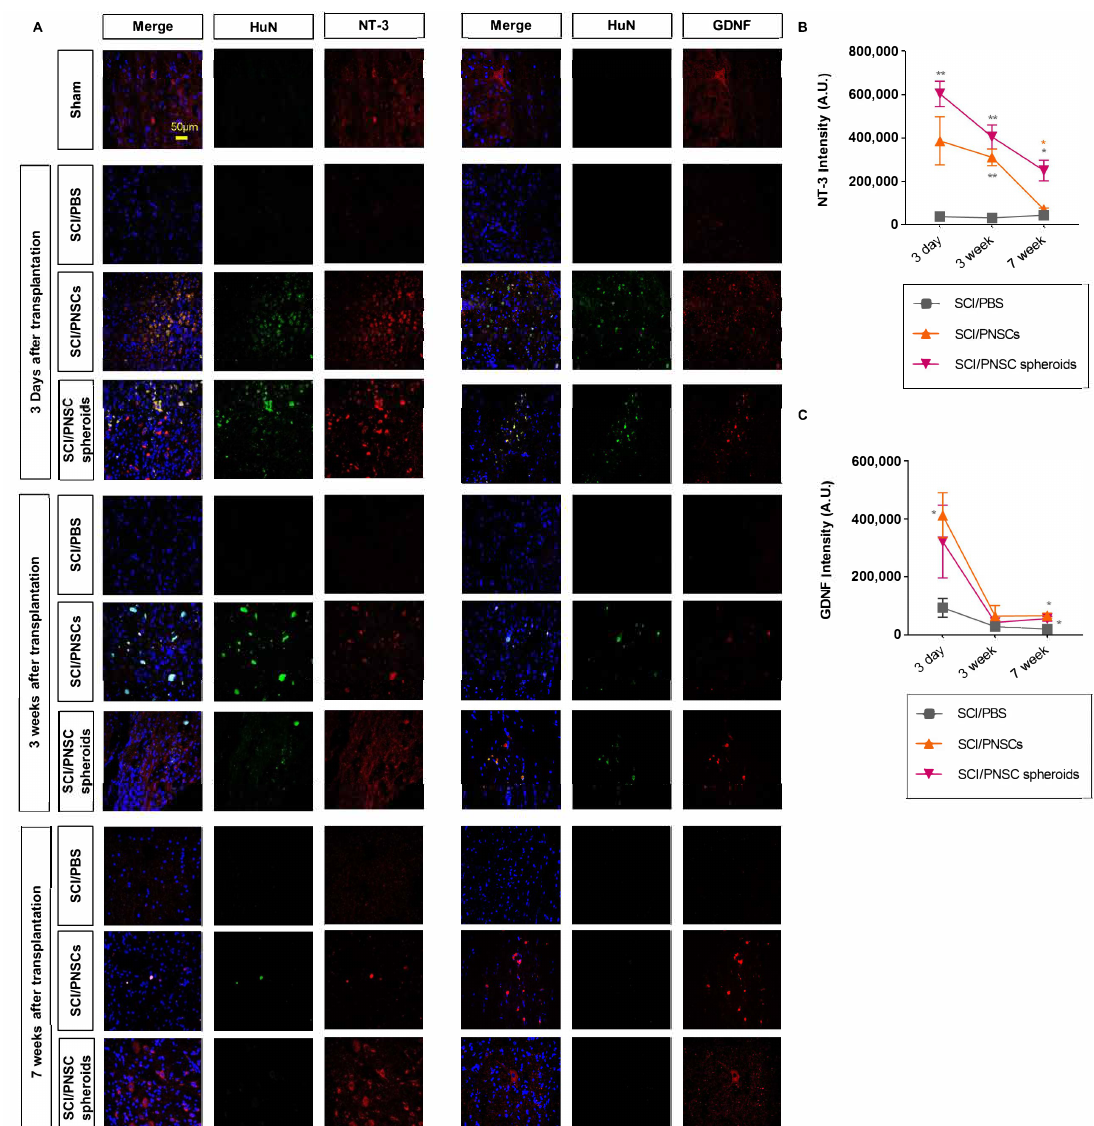
Figure 7. The expressions of GDNF and NT-3 after SCI. ( A ) Representative confocal imaging, with blue indicating DAPI, green indicating HuN, and red indicating either NT-3 or GDNF. ( B ) Total NT-3 staining intensity, with n = 5 for all groups. Data were analyzed using a two-way ANOVA with Holm–Š í d á k’s multiple comparisons. ( C ) Total GDNF staining intensity, with n = 5 for all groups. Data were analyzed using a two-way ANOVA with Holm–Š í d á k’s multiple comparisons. All data are expressed as mean ± S.E.M.; * p < 0.05, ** p <